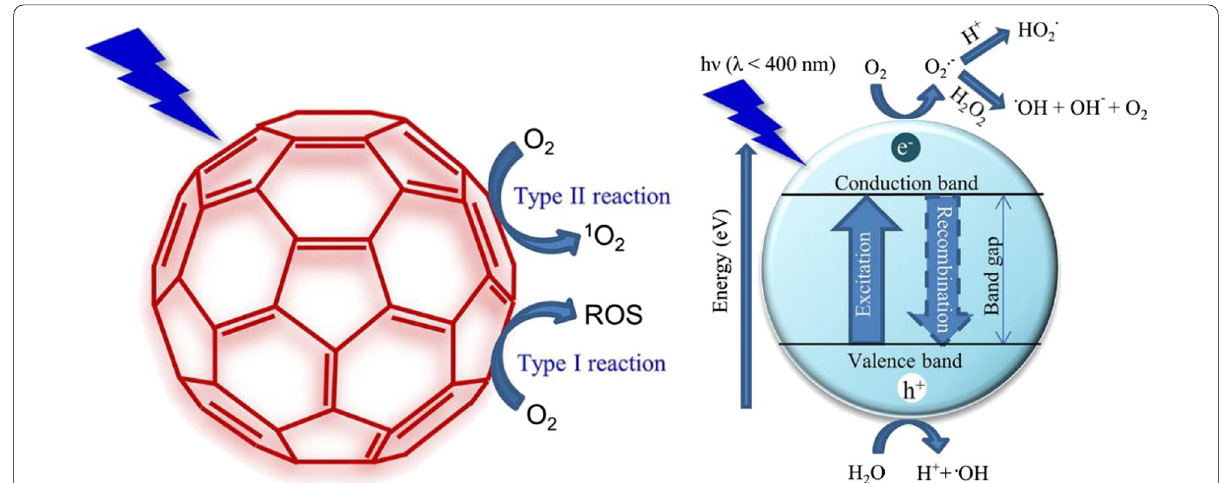
Fig. 8 Schematic illustration of producing reactive oxygen species (ROS) for the photodynamic therapy (PDT)